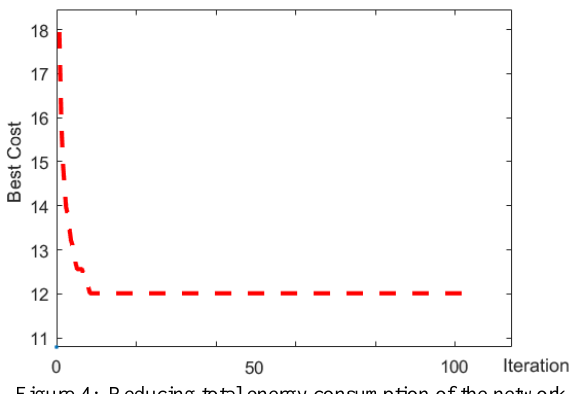
Figure 4: Reducing total energy consumption of the network over 100 iterations using the K-means